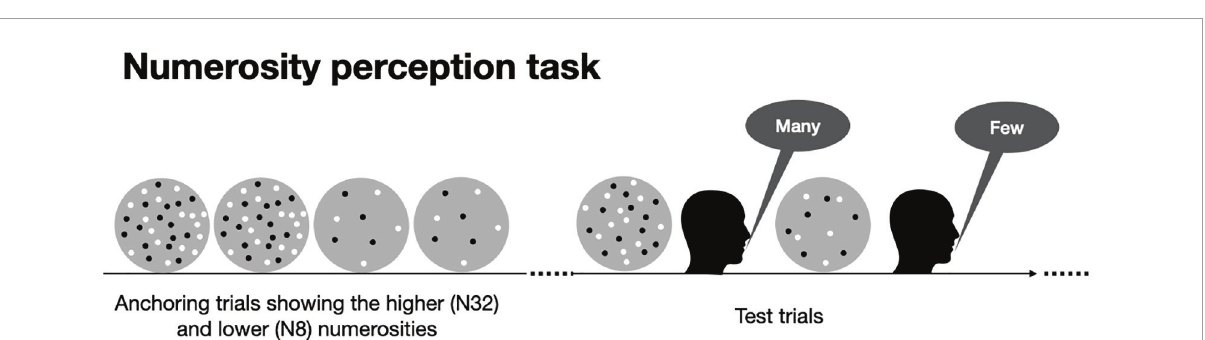
FIGURE3 Numerosity perception task. A block consisted of four initial “anchoring” trials in which the more numerous (N32) and the less numerous (N8) stimuli were presented twice (participants were told that those numerosities corresponded to the range extremes). After that the testing phase started. On each test trial, while participants fixated on a central point on the screen a dot ensemble (with a numerosity randomly drawn from a pre-defined distribution: N8-32, geometric mean N16) was briefly presented (500 ms) and participants were asked to verbally categorize the stimulus as containing “many” or “few”